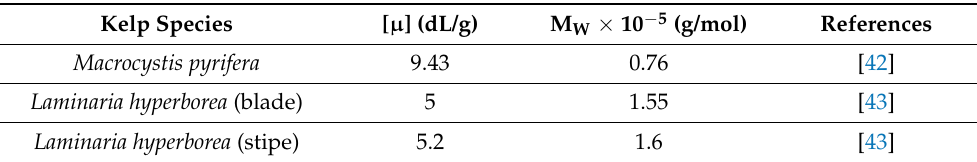
Table 4. Intrinsic viscosity and molecular weight of the extracted alginates compared to data from various kelp